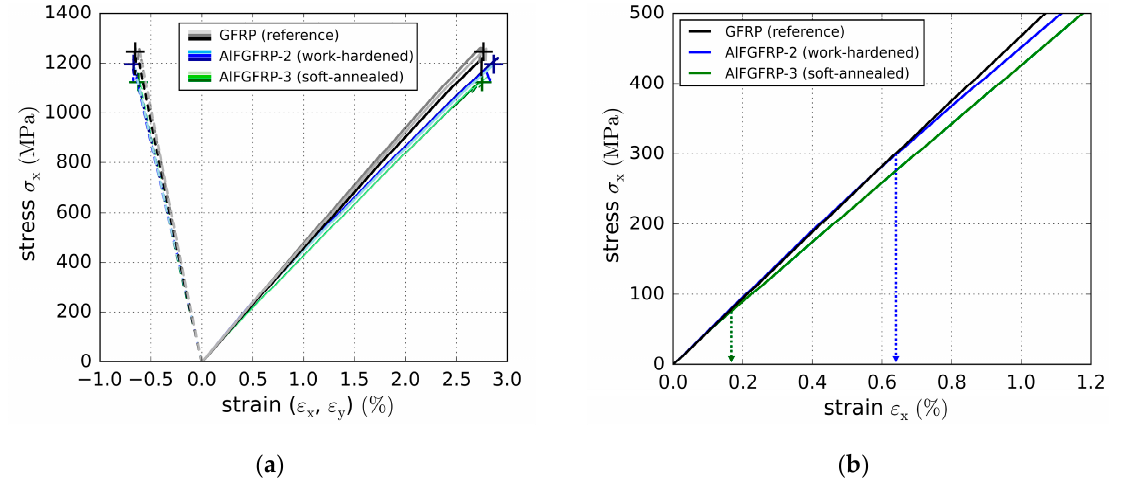
Figure 11. Stress–strain results of the reference laminate and aluminum-reinforced laminates con- taining the soft-annealed and work-hardened wire tested under fiber-parallel tension: ( a ) original stress–strain plot showing the longitudinal (solid lines) and transverse stress–strain curves (dashed lines); ( b ) enlarged plot of the lower stress–strain region. Table 4. Results of the longitudinal tensile tests.